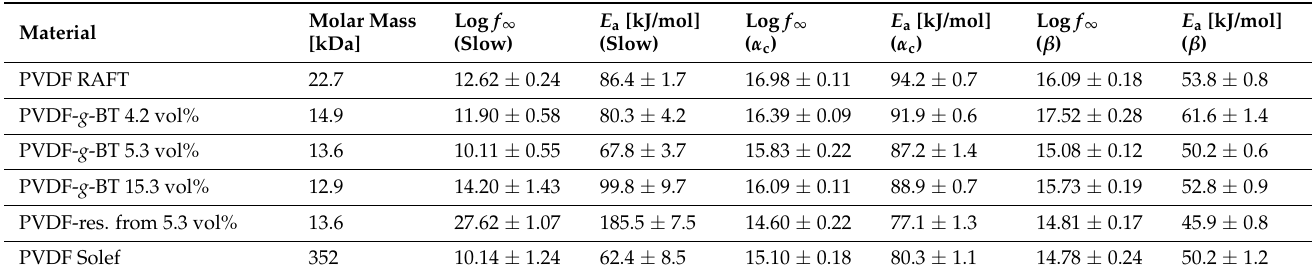
Table 3. Logarithmic relaxation frequency at infinite temperature (log f ∞ ) and activation energy ( E a ) obtained by Arrhenius best fitting of the three observed relaxation processes (as from Figure 4) for RAFT PVDF, PVDF- g -BT nanocomposites, residual ungrafted PVDF, and commercially available PVDF